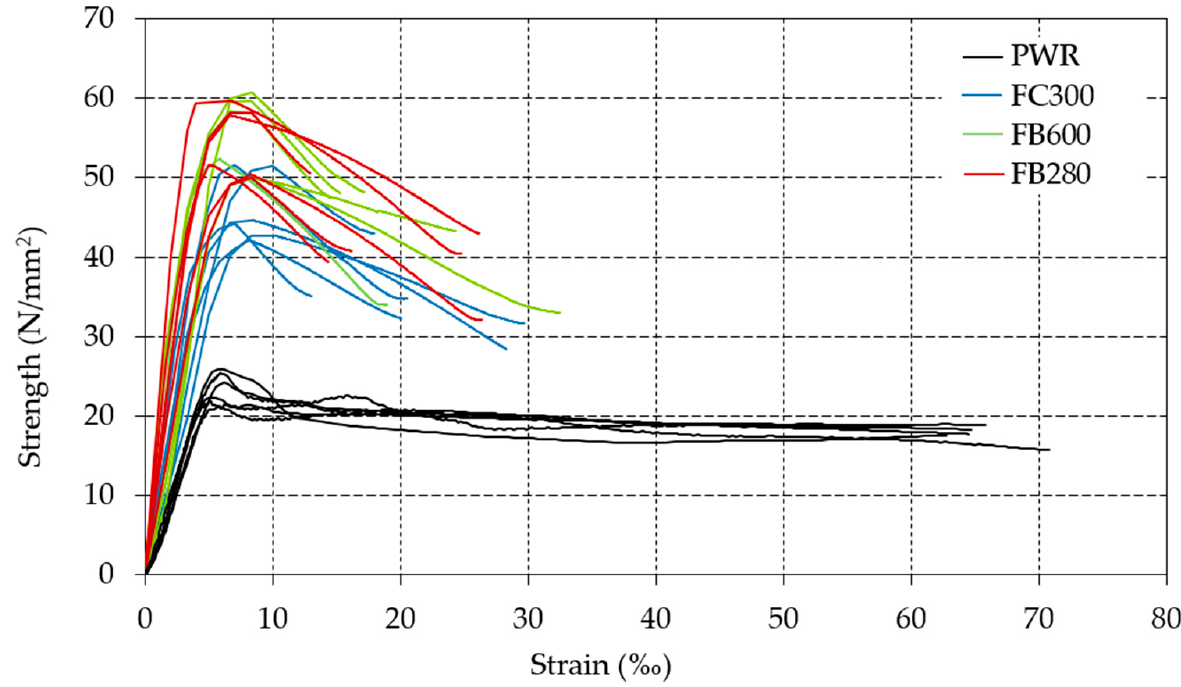
Figure 3. Strength–strain graphs for all of the pieces subjected to compression testing.